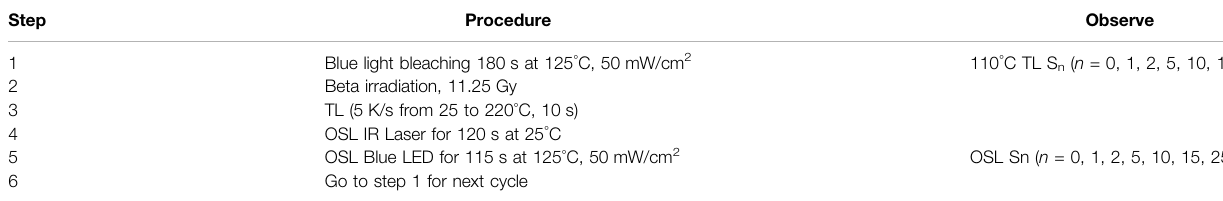
TABLE 1 | Protocol for measurements of quartz luminescence sensitivity (QLS) and sensitivity response to irradiation-bleaching cycles (IBC).